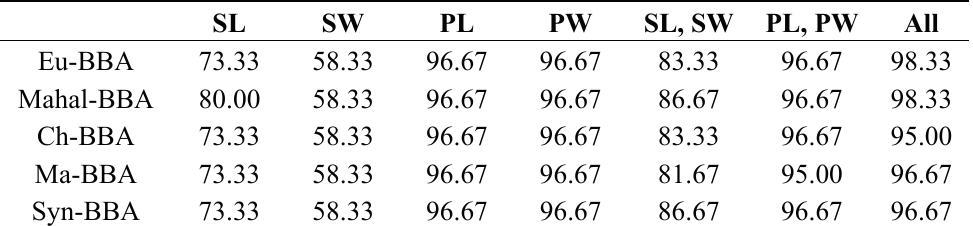
Table 1. Accuracies of the BBAs obtained for the IRIS data (%). SL SW PL PW SL, SW PL, PW